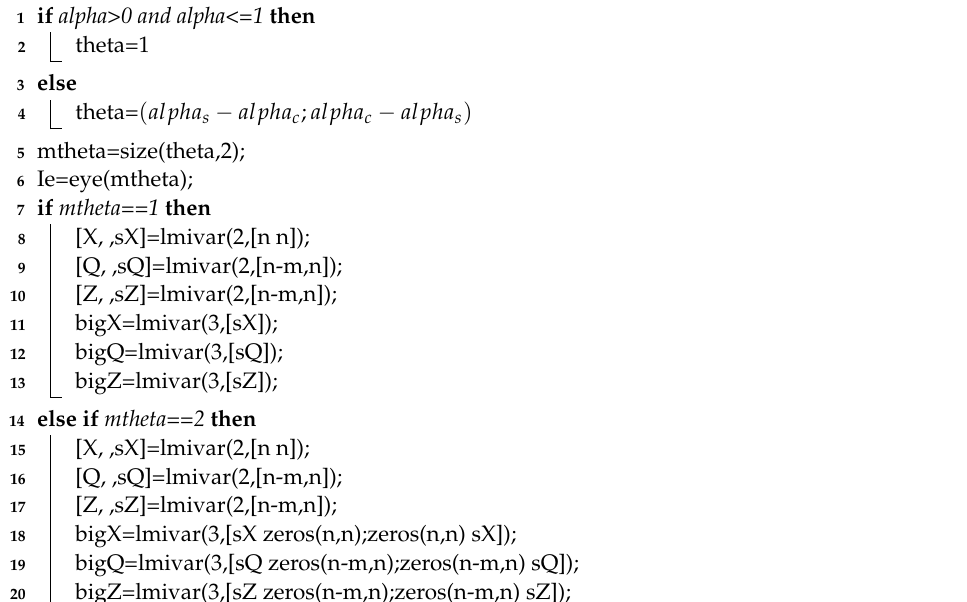
Algorithm A1: The partial LMI algorithm for solving matrices X , Q and Z with Theorem